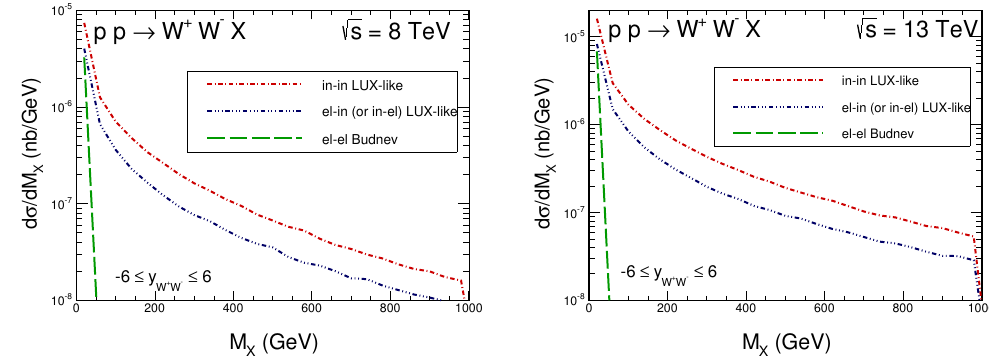
Figure 10 . Missing mass distributions for the inelastic-inelastic, elastic-inelastic, inelastic-elastic and elastic-elastic contributions for the LUX-like structure function. The left panel shows results for W = 8 TeV, while the right panel shows results for W = 13 TeV.